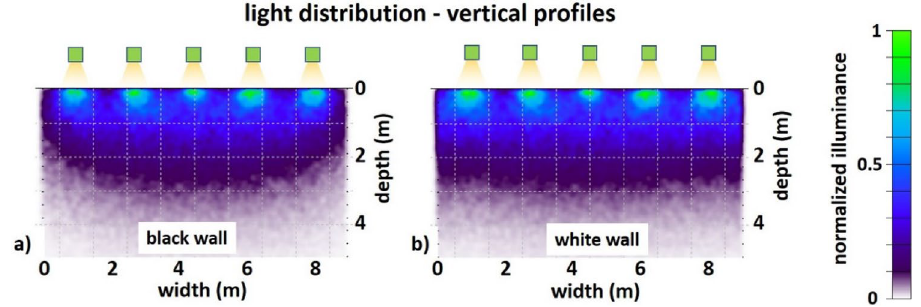
Figure 3. Simulation results side-view. Illuminance distribution in the vertical plane for different wall reflectivities. ( a ) a highly absorbing wall (black), ( b ) a Lambertian wall with high albedo